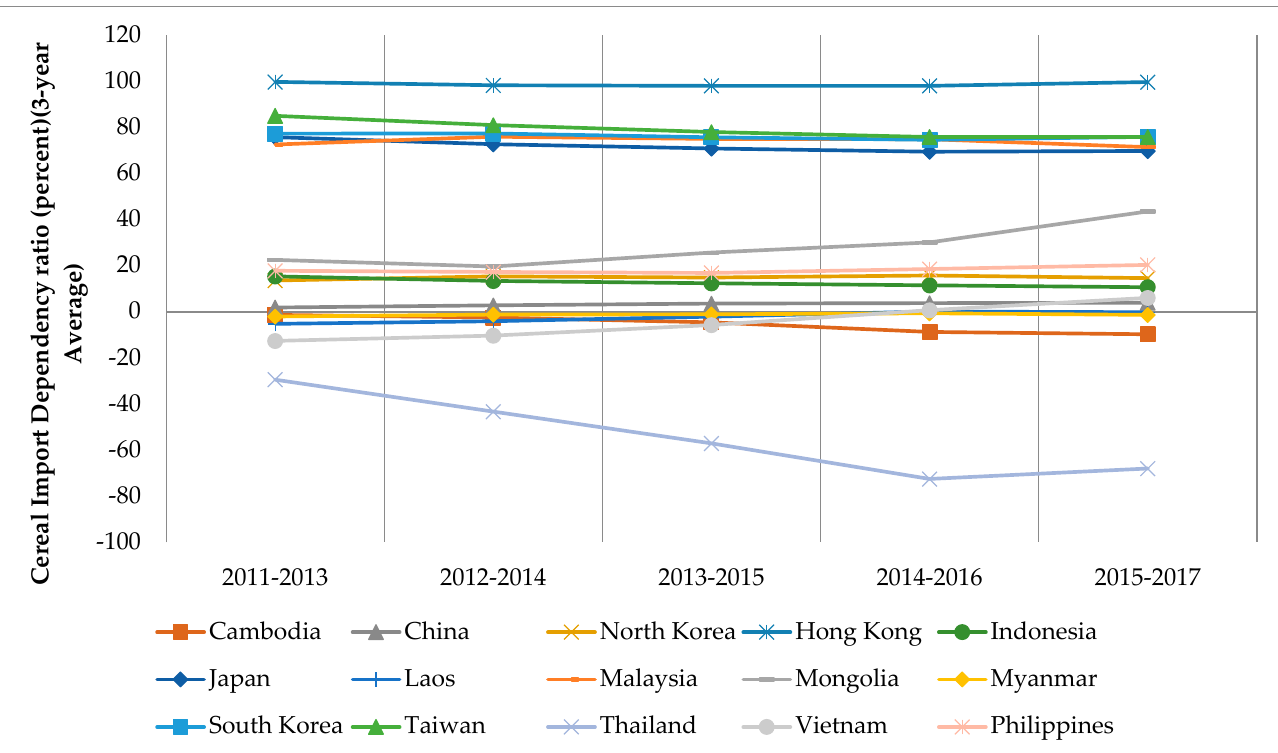
Figure 3. Cereal import dependency ratio for East and Southeast Asian economies in 2017 (Source: data retrieved and adapted from [4]).